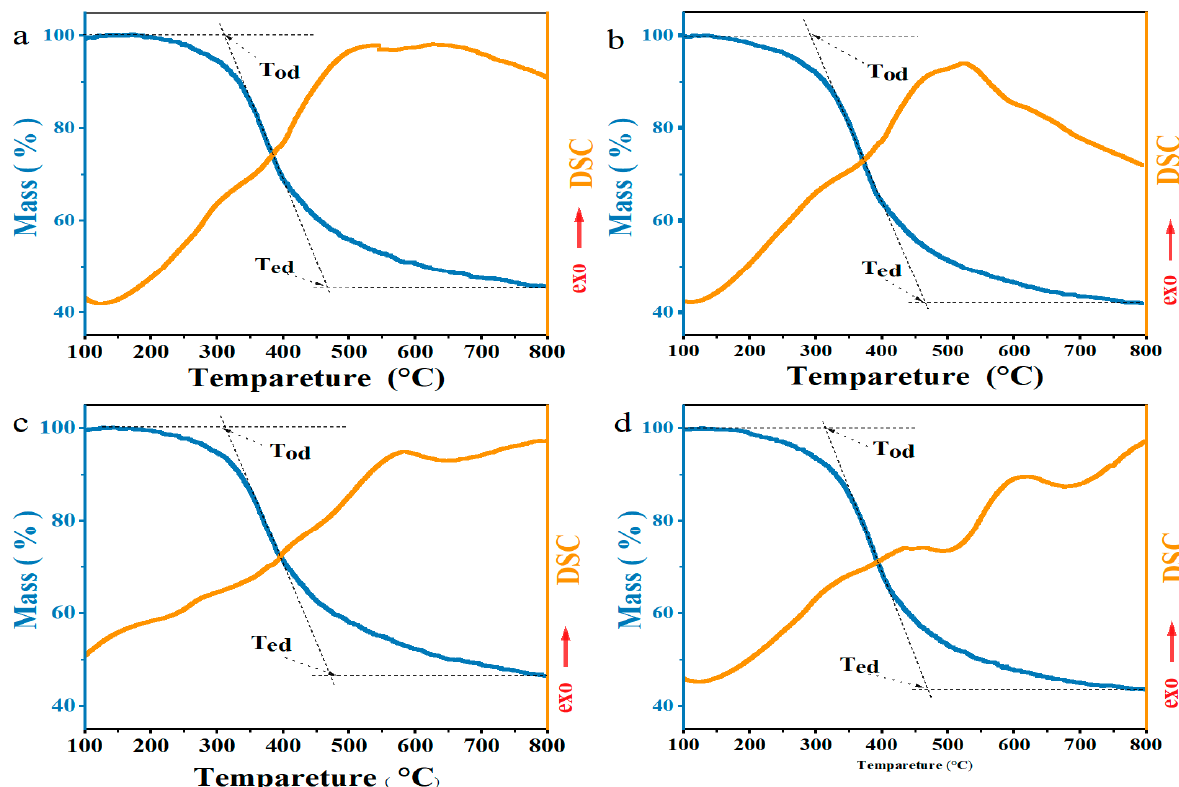
Figure 4. TG and DSC curves of ( a ) LSF-0, ( b ) LSF-0.2, ( c ) LSF-0.4, and ( d ) LSF-0.6. Table 1. Decomposition temperatures and mass loss analysis of the LSF samples.